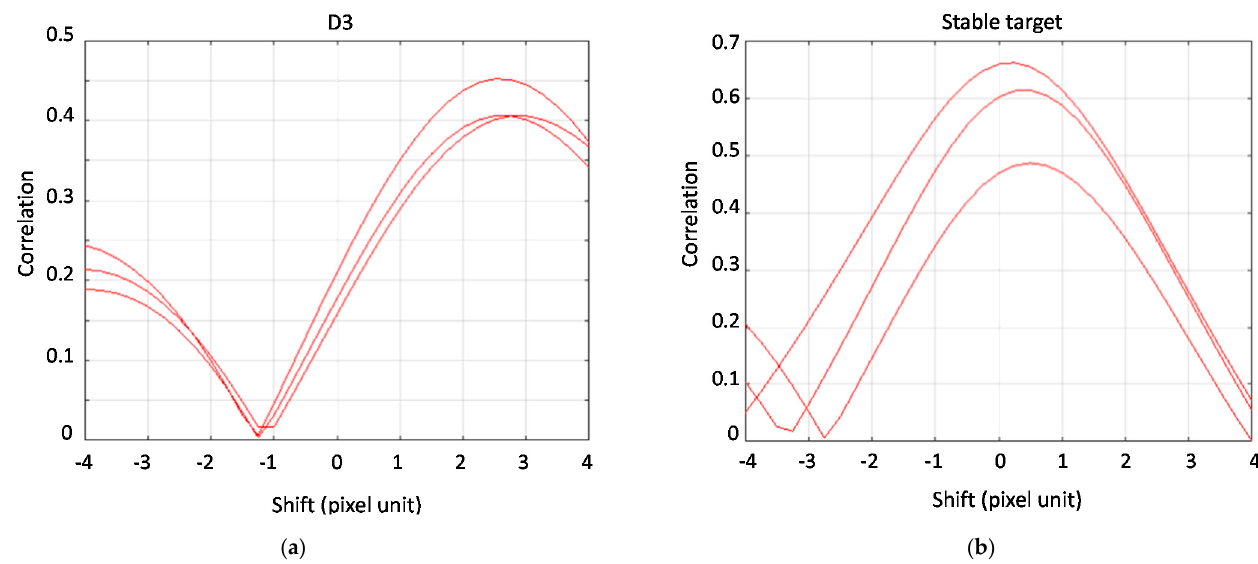
Figure 16. Feature tracking method: displacement in azimuth direction computed for dune D3 ( a ) and a stable target ( b ). The shifts corresponding to the highest correlation values are considered.